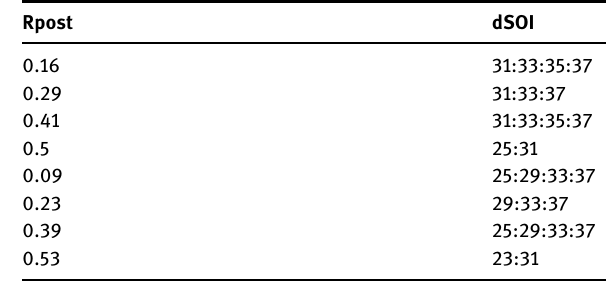
Table 1: Engine speci fi cations